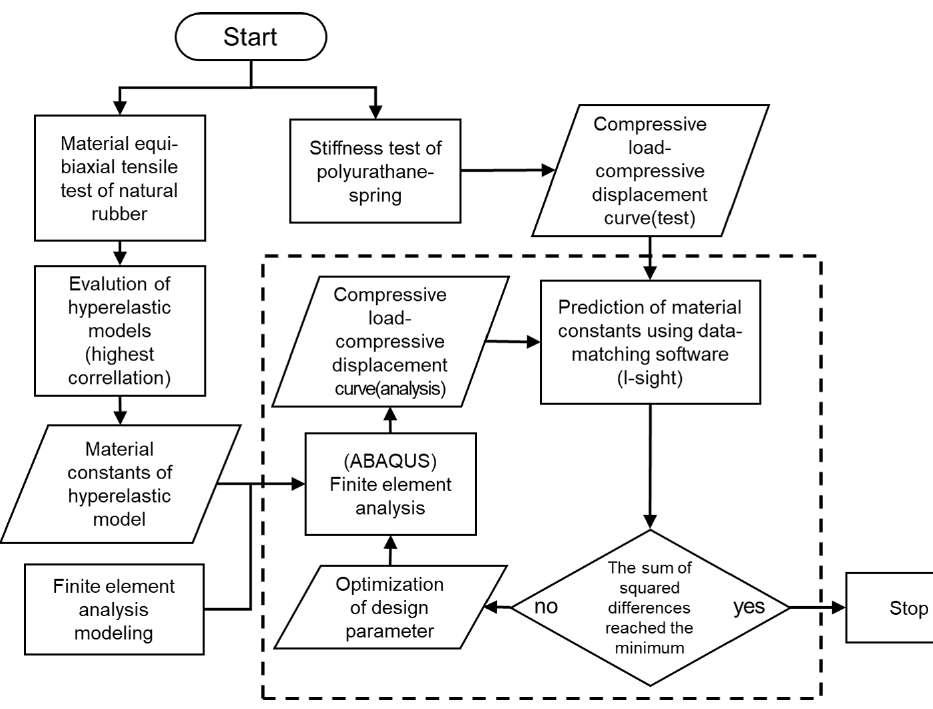
Figure 5. Flowchart of the data-matching optimization procedure.